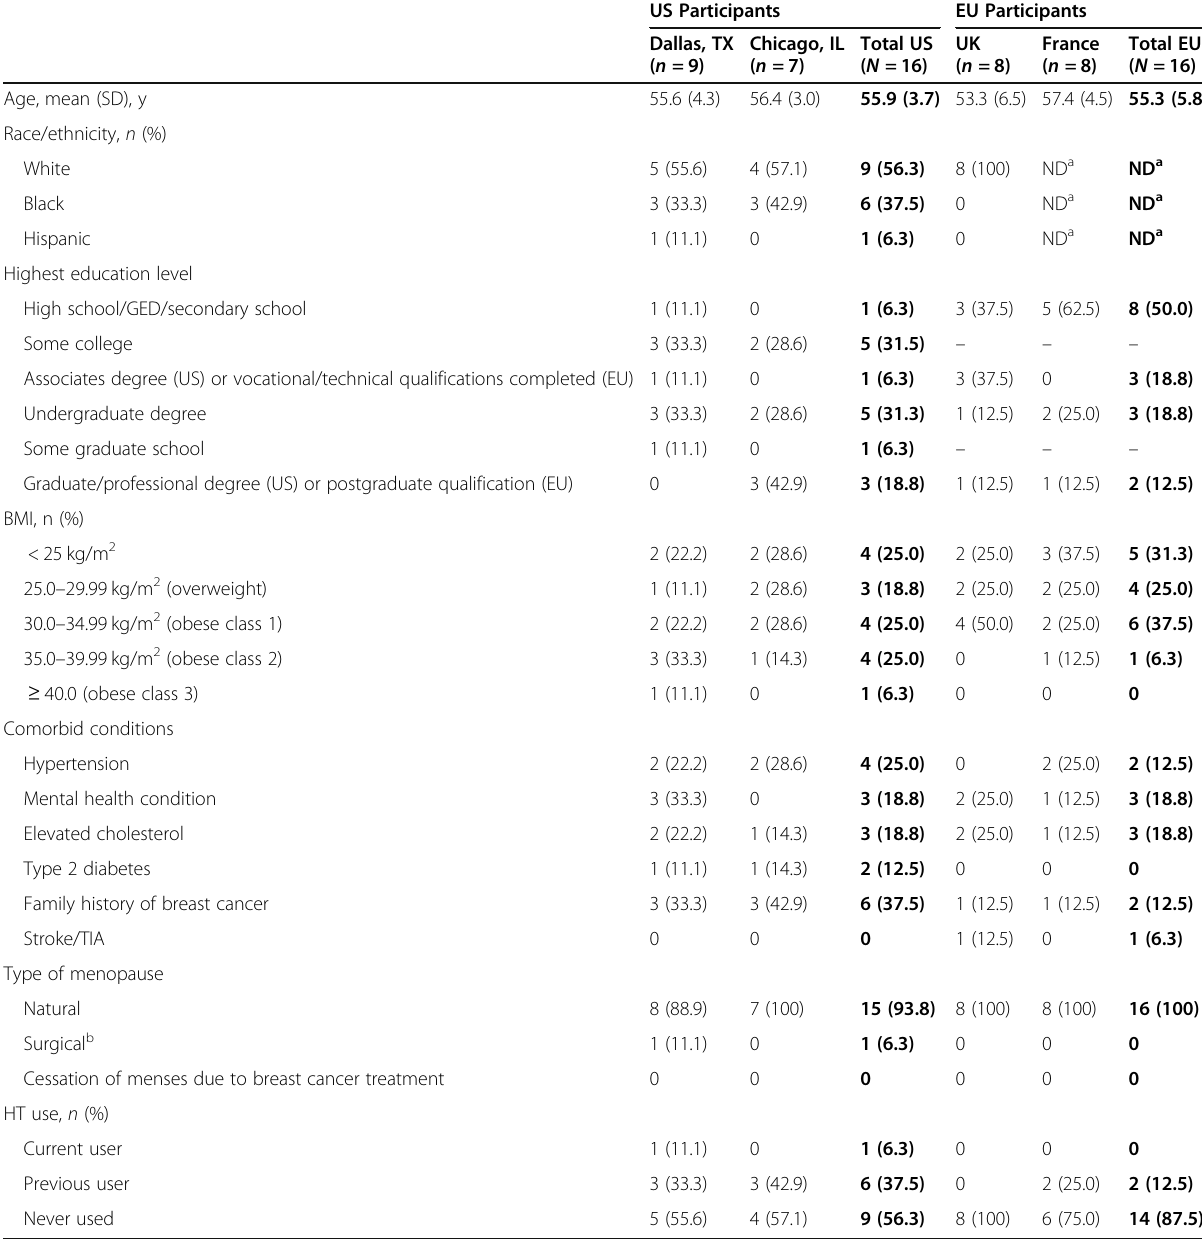
Table 3 Demographic and clinical